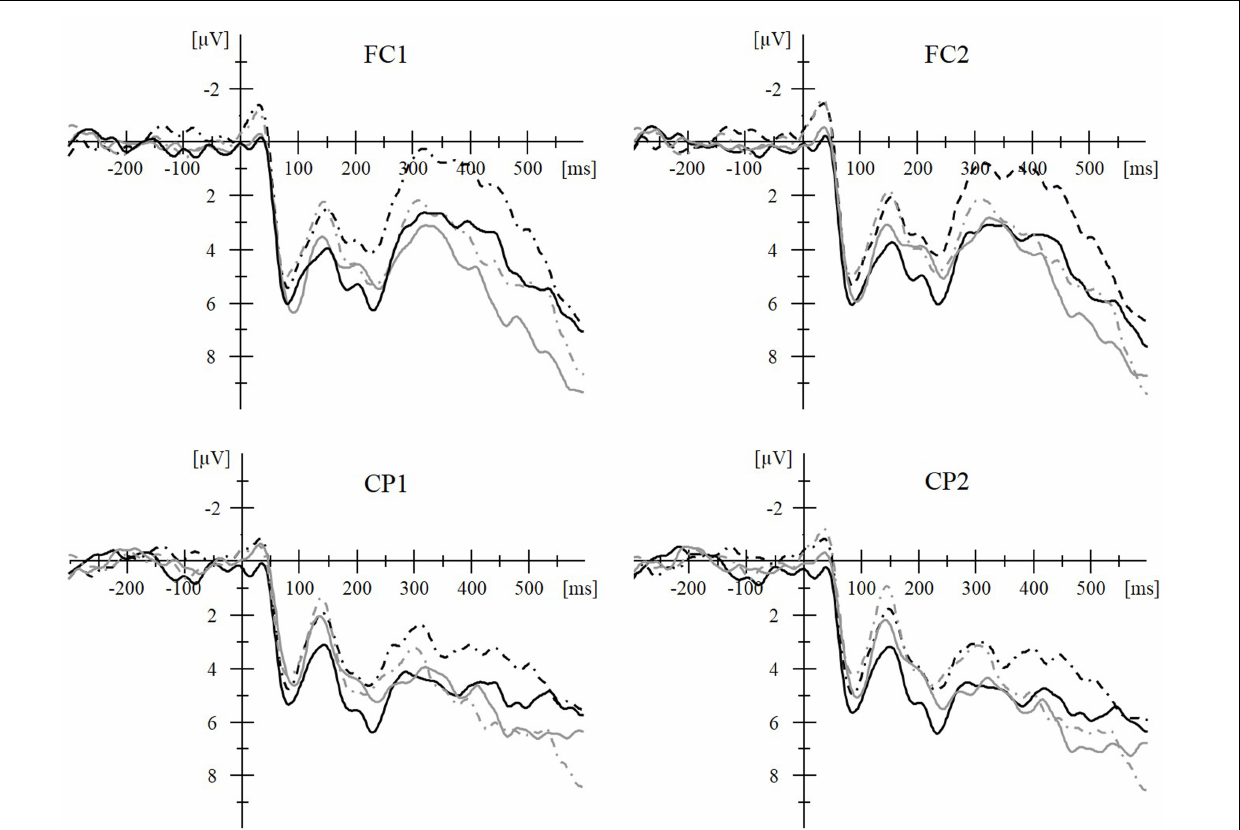
FIGURE 2 |Averaged stimulus-locked event-related potential (ERP) waveforms during a masked priming paradigm demonstrate the online time course of grapheme-to-phoneme-conversion (GPC) during reading aloud. Transparent words (i.e., words with marked vowels) are represented by black lines and opaque words (i.e., words with vowels not marked) by gray lines. For both word types, more negative amplitudes for phoneme-mismatch (O − P − ; e.g.,